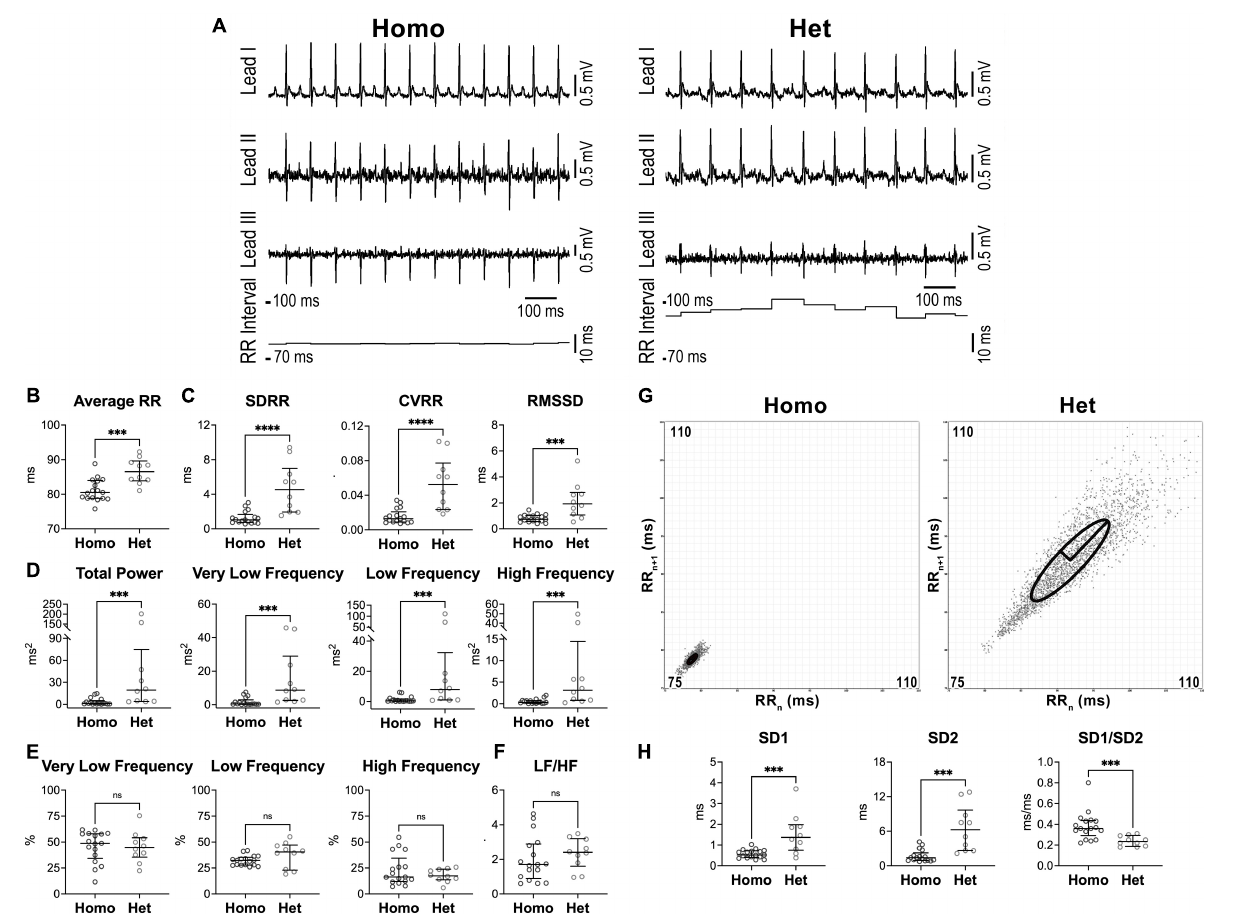
FIGURE 1 | Heart rate dynamics in naïve female Homo and Het mice. (A) ECGs recorded in Homo and Het female mice. Traces for the three leads and RR interval duration are reported. (B) Quantitative data for average RR interval duration. (C) Data for time-domain parameters of HRV. SDRR, standard deviation of RR intervals; CVRR, coefficient of variation of RR intervals; RMSSD, square root of the mean of the squared differences between adjacent RR. (D) Data for frequency-domain parameters of HRV. (E) Data for frequency bands normalized by total power. (F) Data for LF/HF ratio. (G) Poincaré plots obtained from ECGs recorded from female Homo and Het mice reported in A. RR n and RR n + 1 axes span from 75 to 110 ms. (H) Data for non-linear indices. Quantitative data were obtained from naïve Homo ( n = 17) and Het ( n = 10) female mice. Data are shown as scattered plots with median and interquartile ranges. ns, not significant, ∗∗∗ P < 0.001, ∗∗∗∗ P < 0.0001 using unpaired t -test or Mann-Whitney